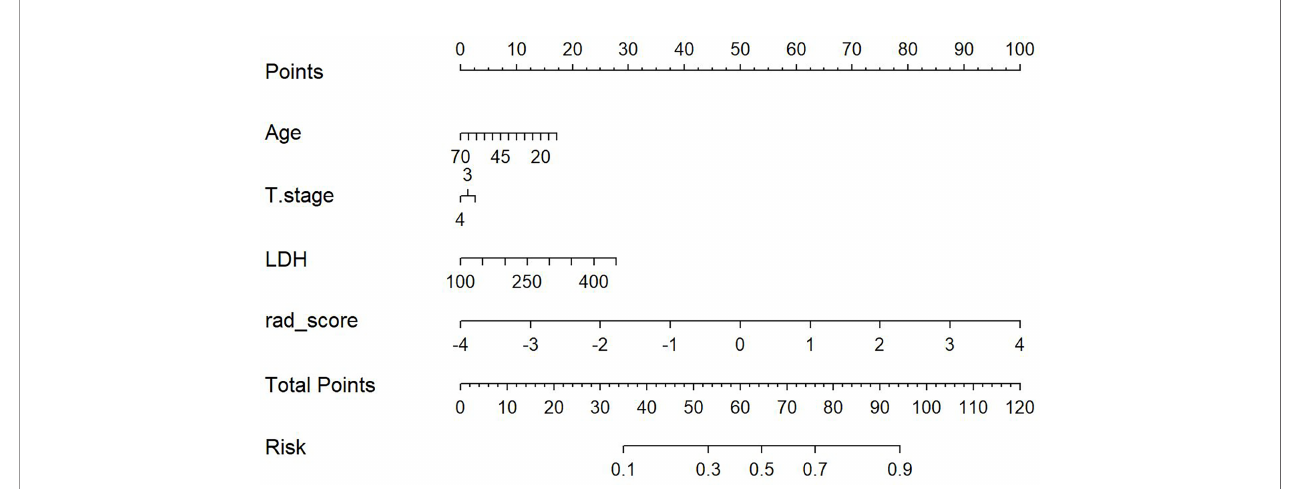
FIGURE 6 | Construction of the model nomogram based on age, tumor (T) stage, and lactate dehydrogenase (LDH) level combined with the T2-weighted imaging (T2WI) radiomics score